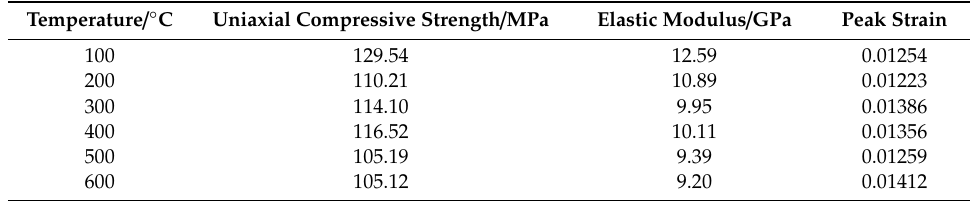
Table 2. Average mechanical parameters of Zhumadian granite at high temperature [38]. Reproduced from [38], Springer Nature 2020.